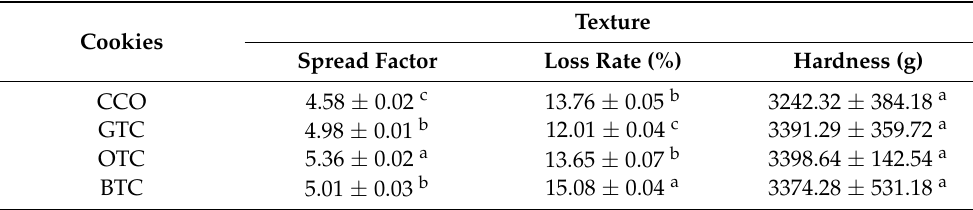
Table 4. Spread factor, loss rate, and hardness of non-gluten shortbread cookies with various spent tea leaf